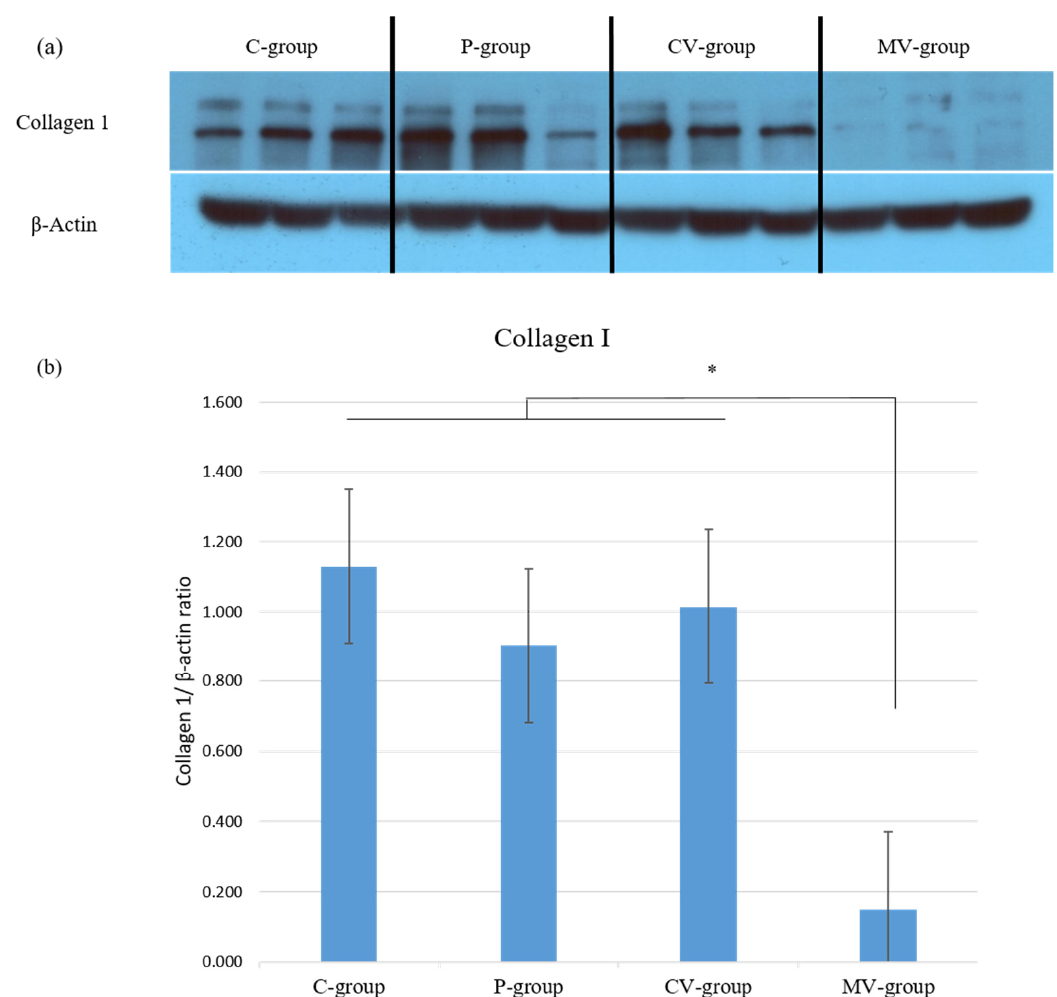
Figure 6. Mortalin-specific shRNA-expressing Ad decreased the expression of collagen type I in rat incisional scar model. ( a ) Collagen type I expression was evaluated among the four groups using Western blotting; ( b ) The expression of collagen type I was significantly decreased in the MV-group versus the C-, P- and CV-groups (* p < 0.05). Data are expressed as mean ± SD ( n = 5). * p < 0.05 indicates statistically significant differences as compared with the control group.